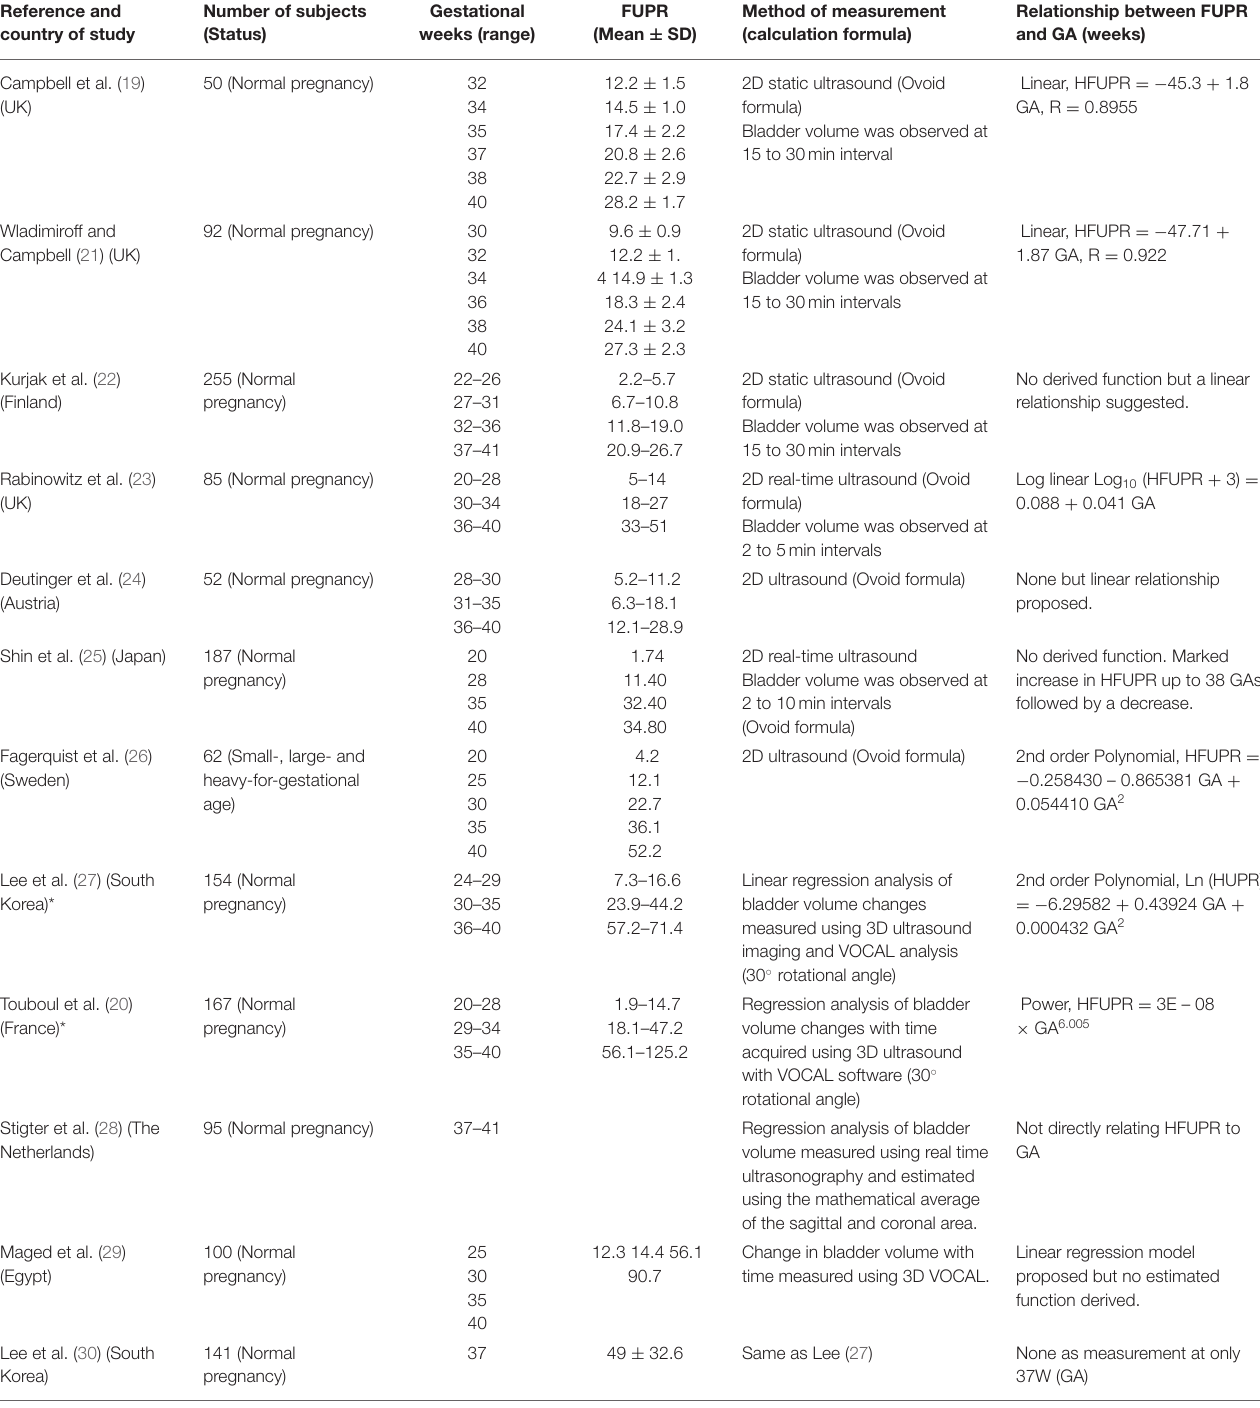
TABLE 1 | Summary of studies with measured values of fetal urine flow rates (ml/h) at different gestational ages in normal pregnancy. Reference and country of study